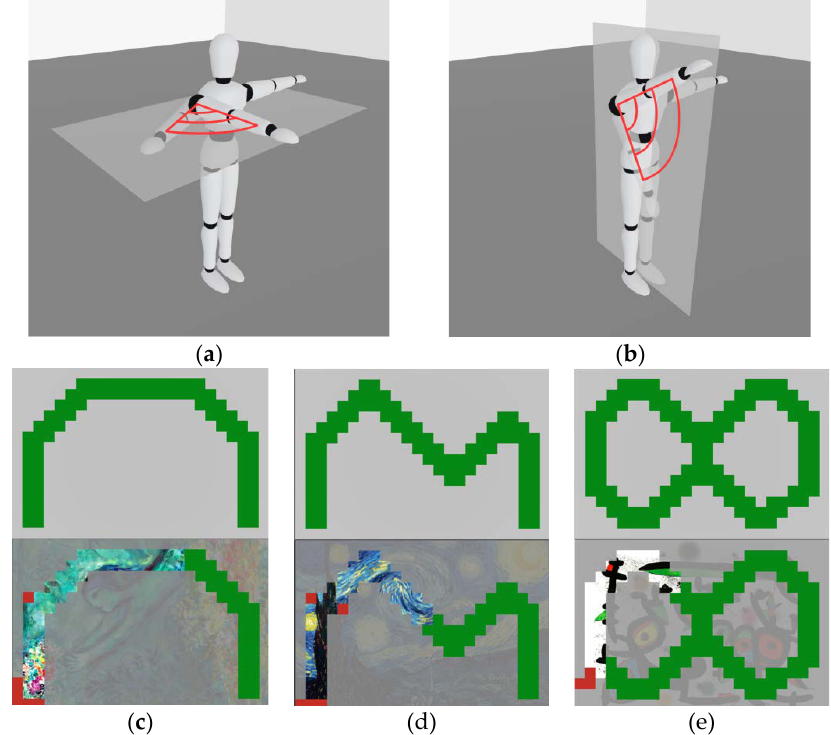
Figure 6. Details of the shoulder ROM rehabilitation: the transverse ( a ) and sagittal ( b ) planes of motion and their relative shoulder movements, and the virtual trajectories ( c – e ) implemented in the AR rehab app (“single arch”, “double arch”, and “infinity symbol”).